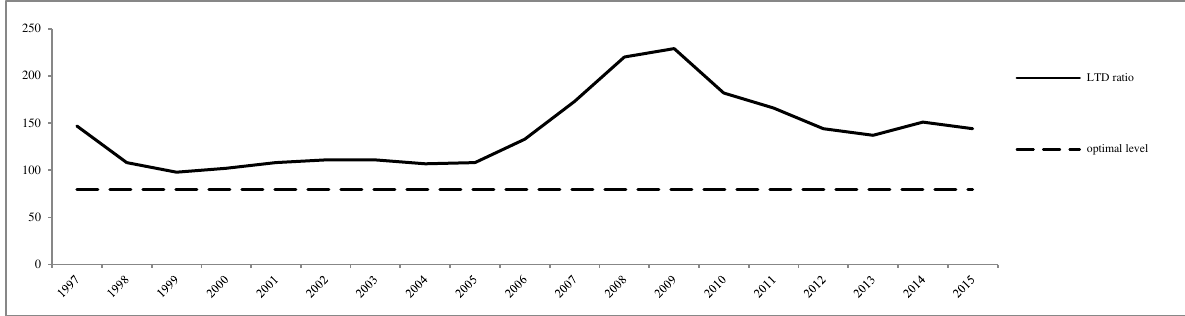
Fig. 2. LTD ratio in the banking system of Ukraine in